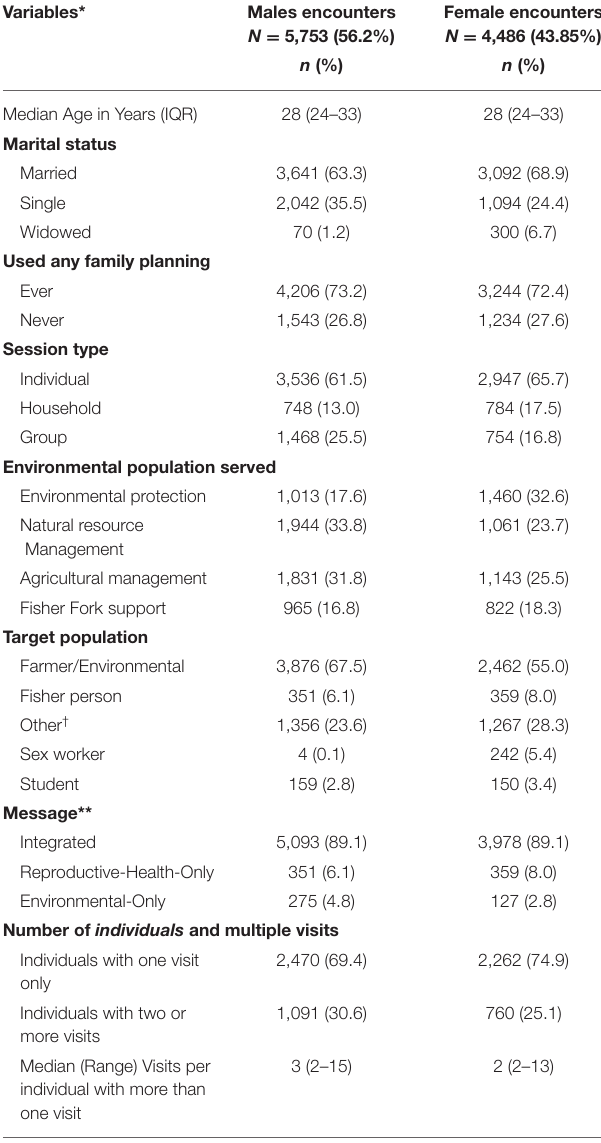
TABLE 1 | Distribution of encounter-level client factors from April 2015–May 2016, N =